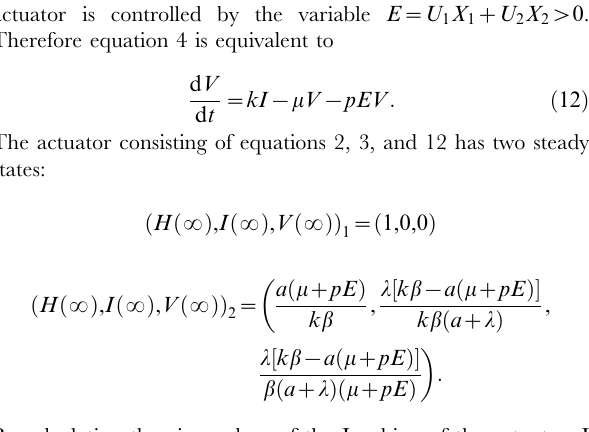
Figure 2. Time courses of the healthy cell concentration H ð Þ , the infected cell concentration I ð Þ , the dead cell concentration D ð Þ , the viral load V ð Þ , the concentrations of naı¨ve and memory antibodies X 1 and X 2 ð Þ , respectively, and the naı¨ve antibody affinity U 1 ð Þ . The memory antibody affinity is U 2 ~ 0 : 5 . The initial conditions are the same as those in Figure 1. threshold U 2 ~ 5 : 0 | 10 { 3 below which the cumulative effect of w 100 . The naı¨ve antibodies X Int is in a plateau in which X Int 1 1 variable X Int sharply decreases from 100 to 9 : 0 | 10 { 5 in a 1 narrow region 5 : 0 | 10 { 3 v U 2 v 9 : 3 | 10 { 3 . The variable X Int 2 increases almost linearly with U 2 from 7 : 7 | 10 { 3 ( U 2 ~ 10 { 3 ) to 133.8 ( U 2 ~ 1 : 0 ). The variable X Int 1